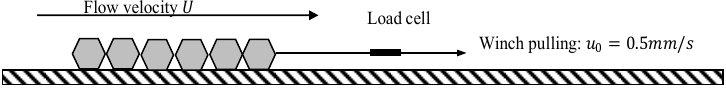
Figure 1. This is a figure. Schemes follow the same formatting.